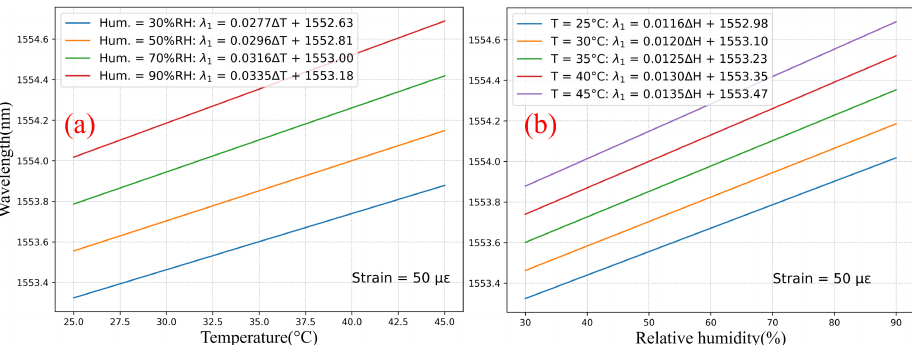
Figure 7. Computation of the CYTOP-FBGs with over-clad (FBG #1) response to ( a ) temperature, and ( b ) humidity within fixed strain